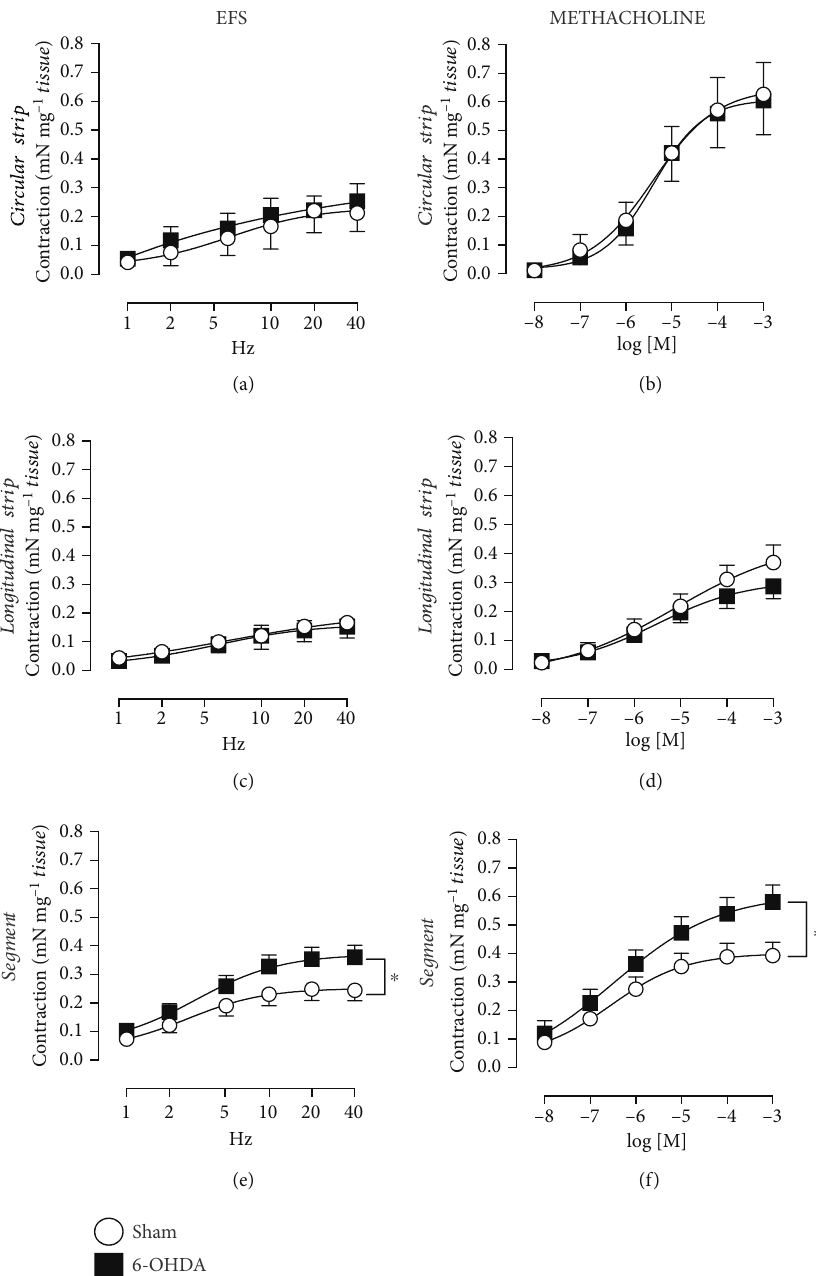
Figure 2: Distal colon contractile responses to electrical fi eld stimulation (EFS) and methacholine. Following EFS, frequency-dependent responses were observed in all tissues. The segments showed signi fi cant di ff erences in the 6-OHDA group in both EFS- (e) and methacholine-induced contractions (f) compared with Sham ( n = 16 and n = 17 , respectively). However, no di ff erences in EFS- and methacholine-mediated contraction were observed between the 6-OHDA and Sham animals in circular (a and b; n = 10 and n = 9 , respectively) and longitudinal strips (c and d; n = 9 and n = 8 , respectively). *=Signi fi cant di ff erence from Sham group; two-way ANOVAs (e) group-concentration interaction ð 5, 155 Þ = 3 : 88 , p = 0 : 0024 ; (f) group-concentration interaction ð 5, 155 Þ = 4 : 38 , p = 0 : 0009